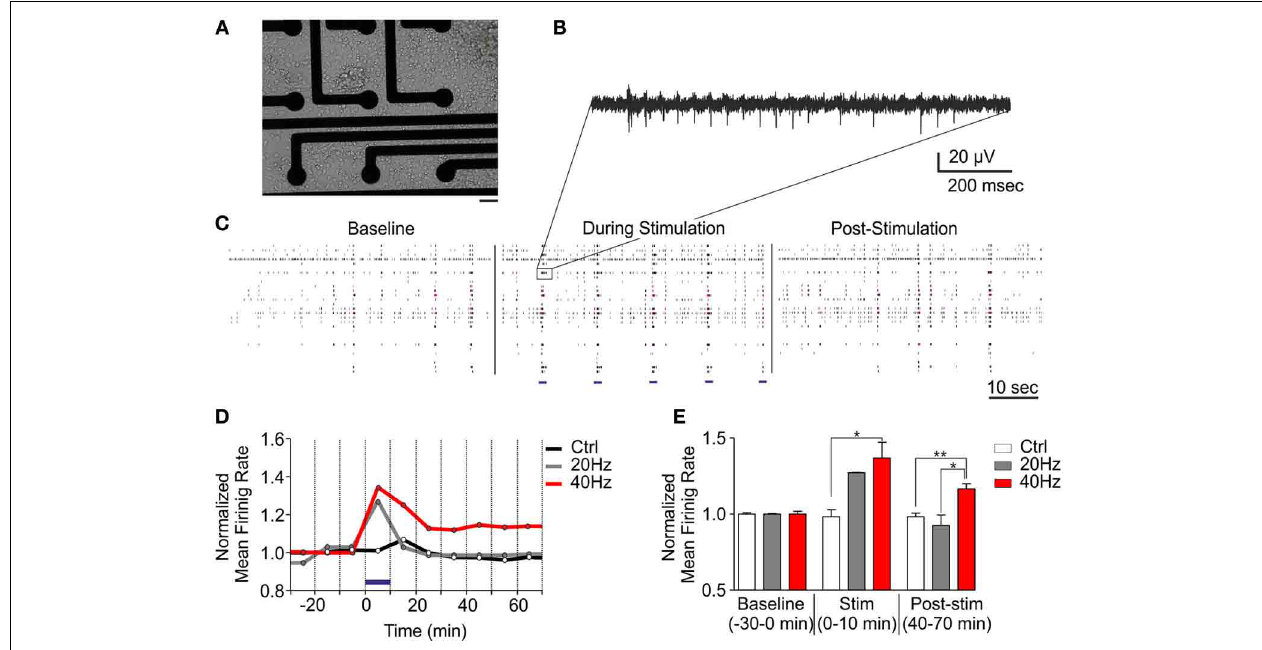
normalized mean firing rate (averaged in 10min bins) during a long-term plasticity protocol consisting of 1s stimulation at either 20 or 40Hz (light pulse duration, 10ms, blue horizontal bar) administered every 10s for 10min (blue horizontal bar). (E) Normalized mean firing rate under basal conditions (baseline), during photostimulation and after (time = 40–70min) stimulation. Means ± s.e.m. are shown. YFP-infected control, 40Hz, n = 5; ChR2/H134R-infected, 20Hz, n = 3; ChR2/H134R-infected, 40Hz, n = 4. ∗ p < 0 . 05, ∗∗ p < 0 . 01, Kruskal–Wallis test followed by the Dunn’s multiple comparison